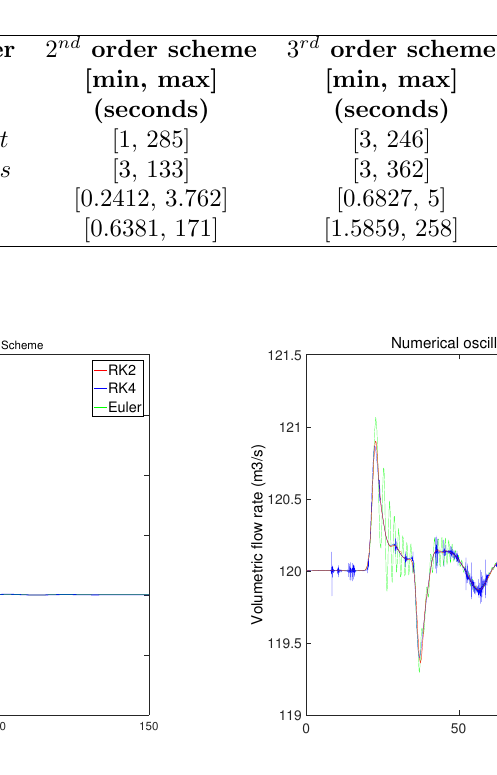
Figure 15: Numerical oscillation for all fixed step- length solvers for 2 nd order KP scheme (Dis- sanayake et al., 2016).